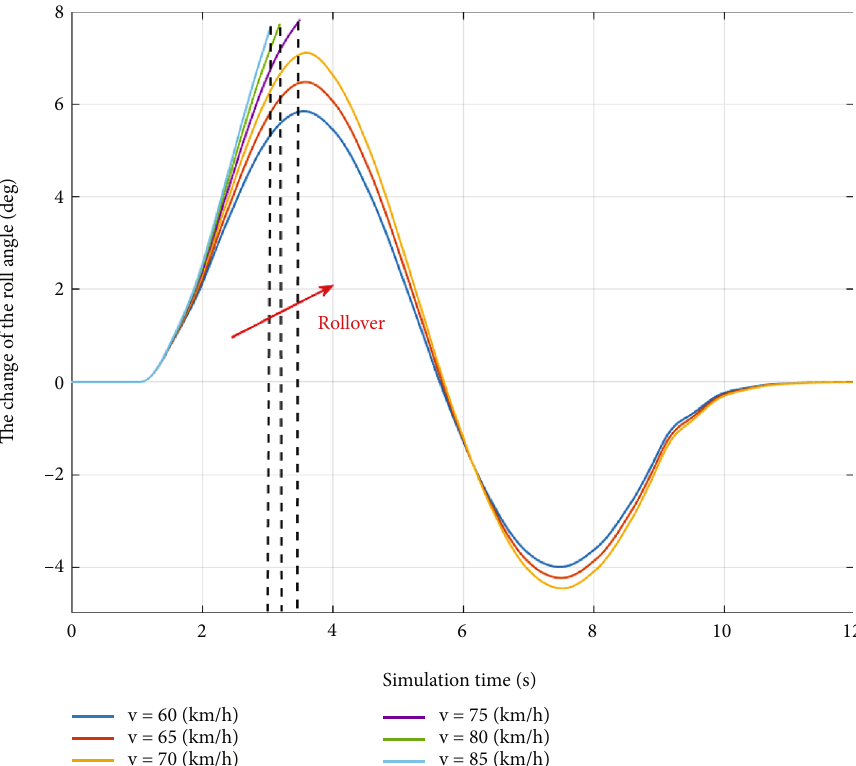
Figure 12: The change of the roll angle (the third case — velocity